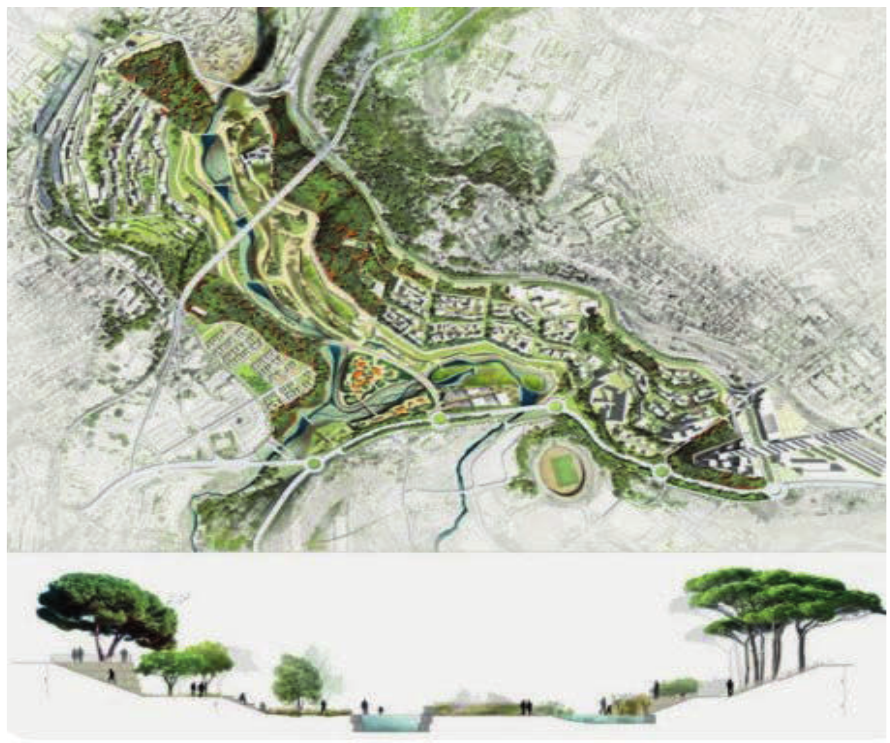
Fig. 6. Urban development of Bardo Park (pinterest.com, n.